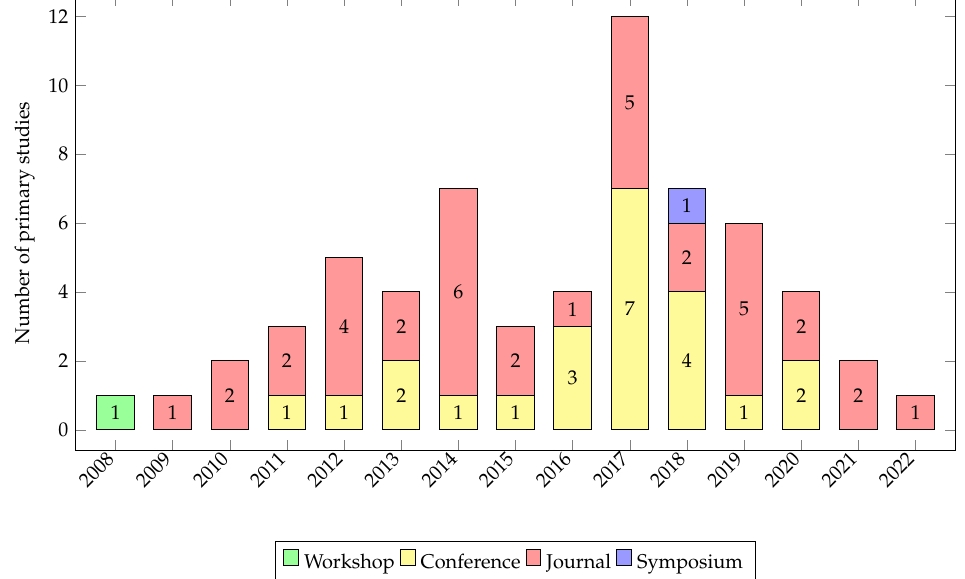
Figure 3. Distribution of publication type.